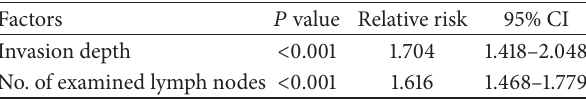
Table 3: Prognostic factors retained in multivariate analysis.